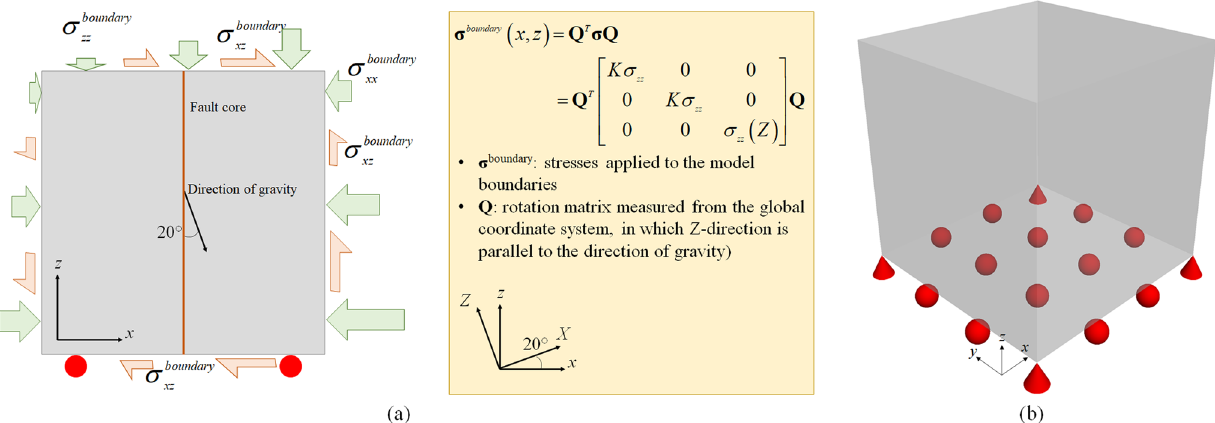
Fig. 5 Boundary conditions to simulate an initial stress state: a Stresses applied to the model outer boundaries b Displacement constraint condi- tion on the bottom